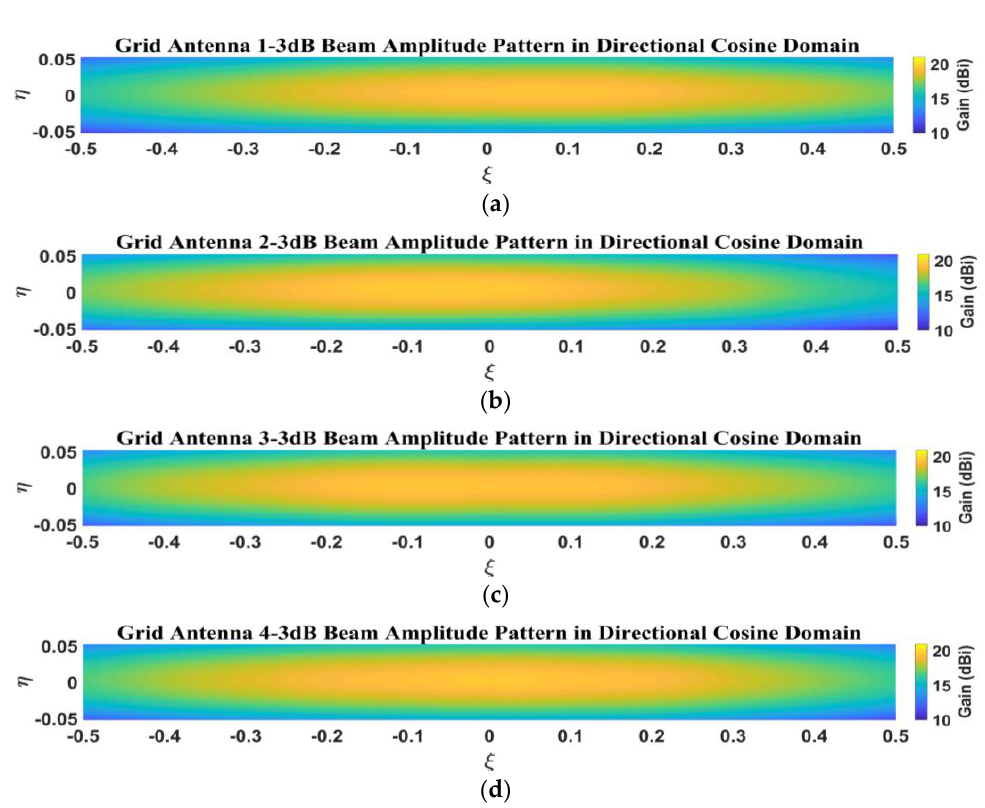
Figure 9. Simulated amplitude pattern of 3-dB beamwidth in direction cosine domain: ( a ) grid antenna 1; ( b ) grid antenna 2; ( c ) grid antenna 3; ( d ) grid antenna 4.